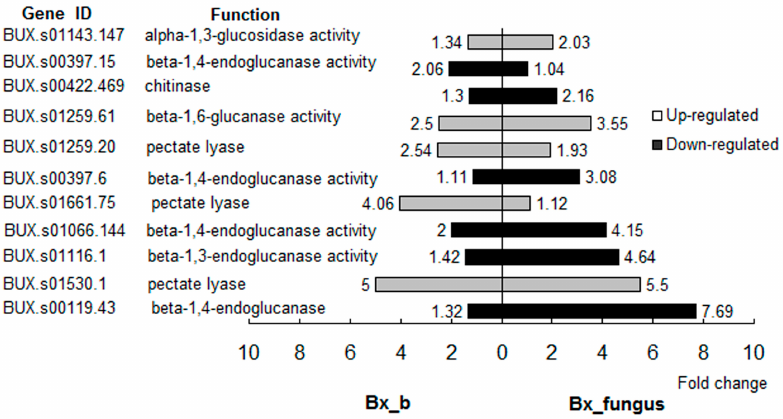
Figure 2. Putative cell wall hydrolase genes in B. xylophilus treated with endobacterium and